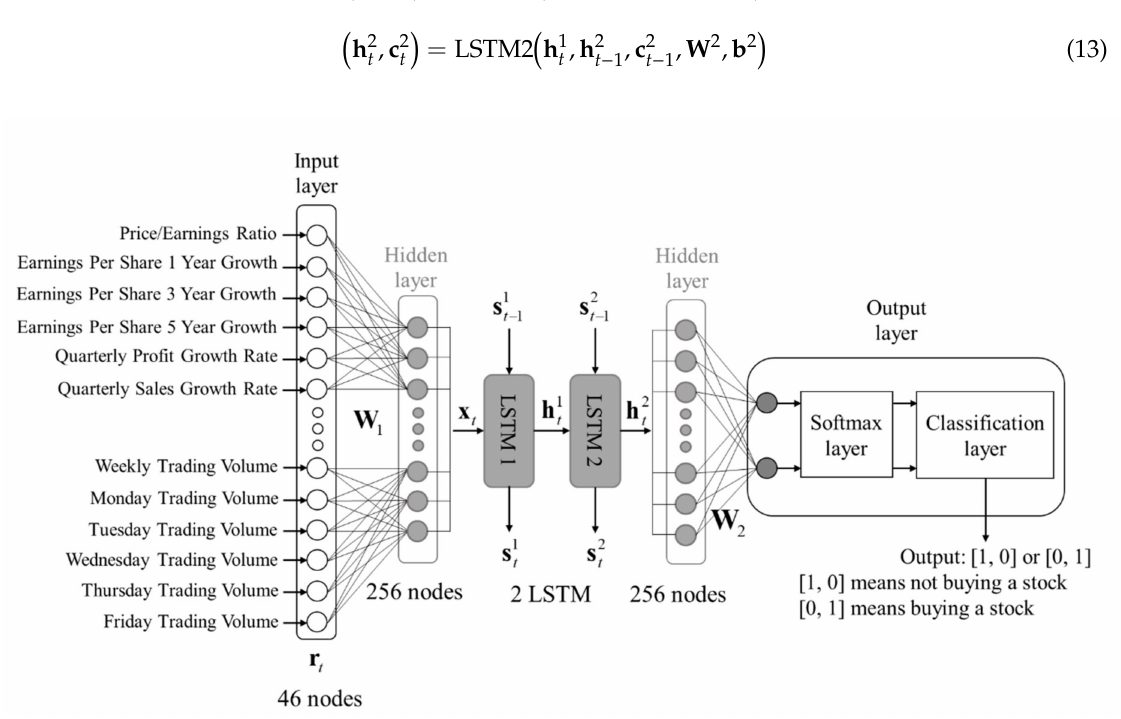
Figure 3. Architecture of double-layer LSTM model for the stock performance